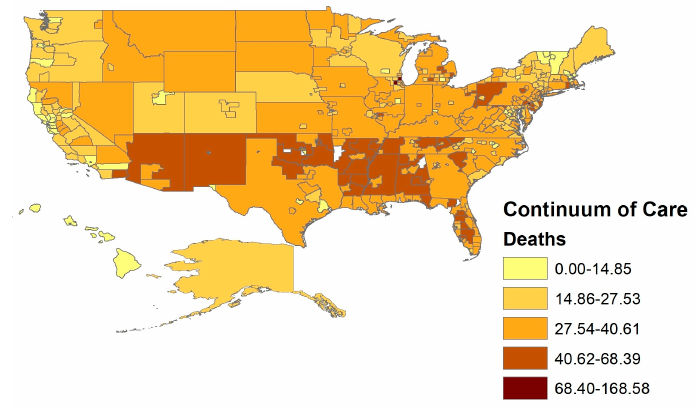
Figure 2. COVID-19 Death Rates by Continuum of Care.